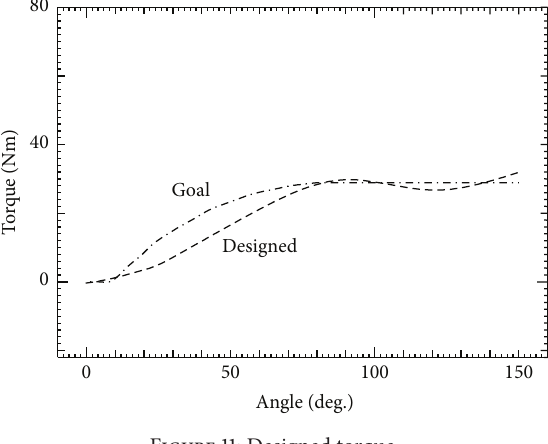
Figure 11: Designed torque.